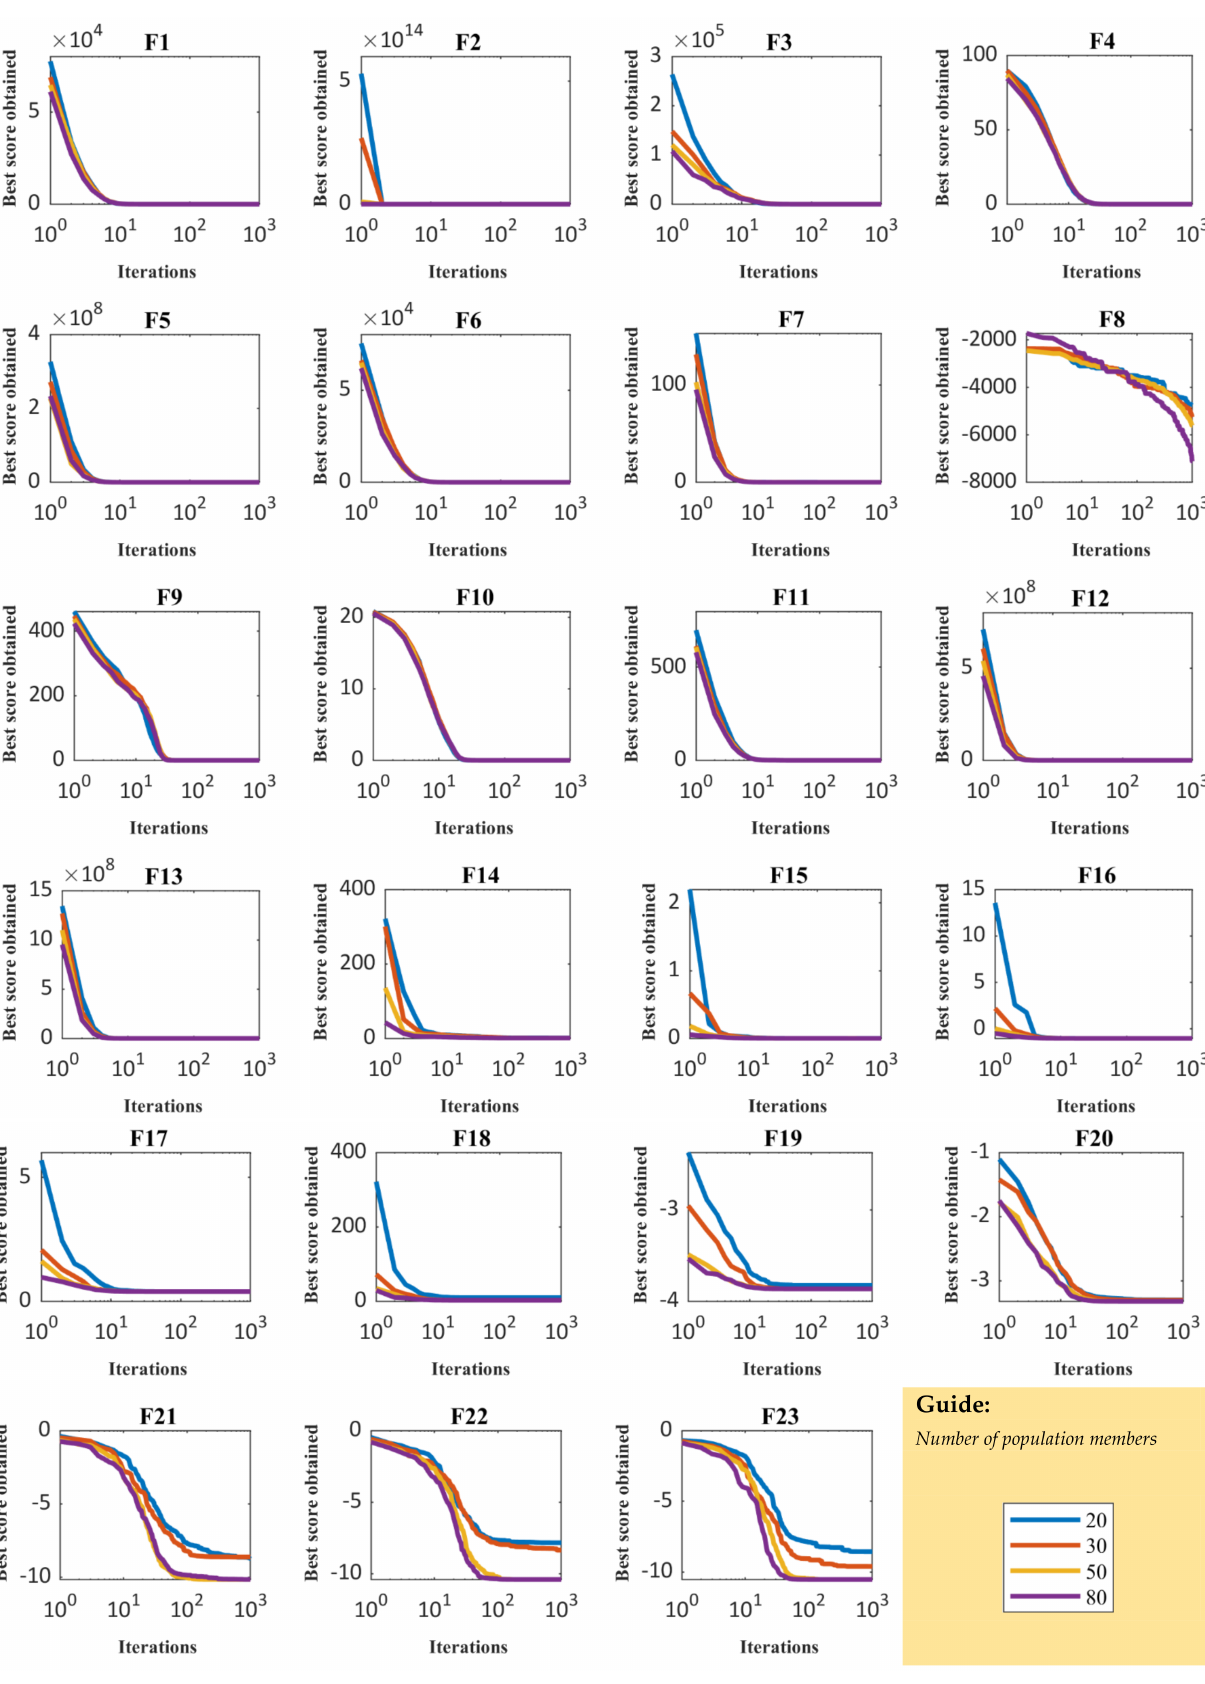
Figure 3. Sensitivity analysis of CMBO for number of population